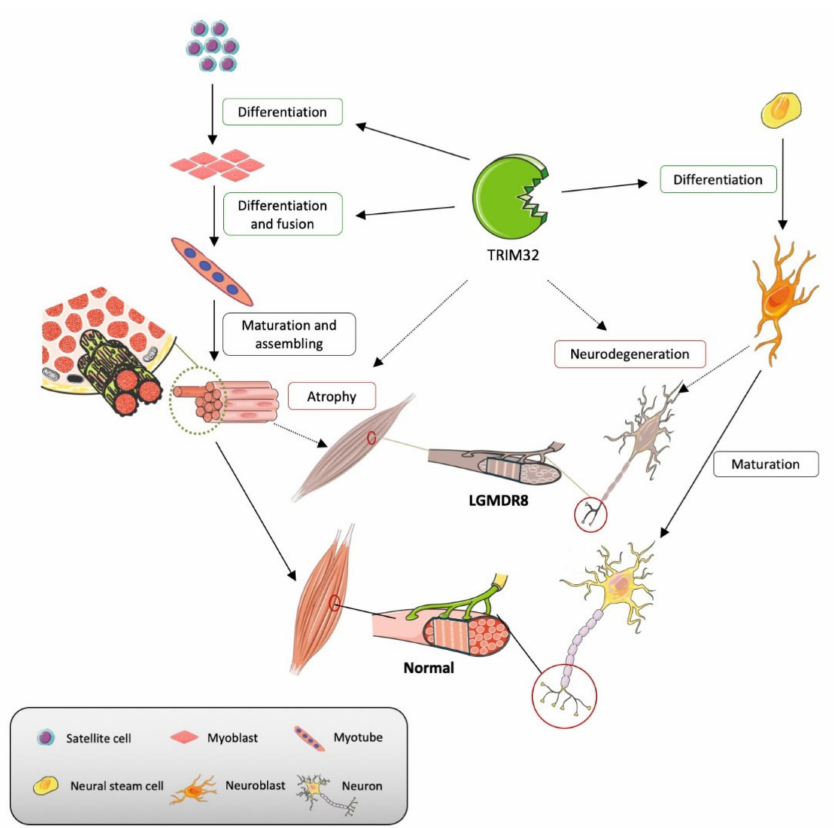
Figure 5. Limb-girdle muscular dystrophy R8 (LGMDR8) and the role of TRIM32 in the context of muscle and neuronal differentiation/degeneration. The activated satellite cells differentiate into myoblasts and then fuse together to form myotubes. The myotubes further mature and assemble into myofibers. The neural stem cells are activated and differentiate into neuroblasts, then further mature into neurons. TRIM32 is involved in these physiological processes through regulating differentiation and fusion (green boxes). Dysfunction of TRIM32 will disrupt normal neuromuscular system growth and possibly induce atrophy and neurodegeneration, which causes the occurrence of LGMDR8 (red